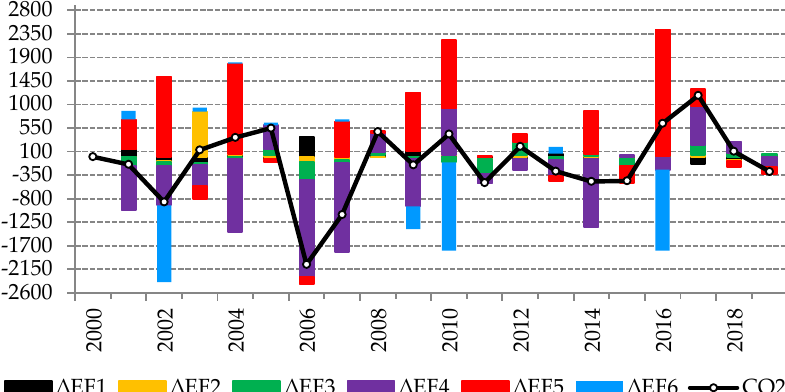
Figure 4. Graphical presentation of the decomposition of changes in CO 2 emissions from energy consumption in Polish agriculture in 2000 – 2019 ( annual effects ).